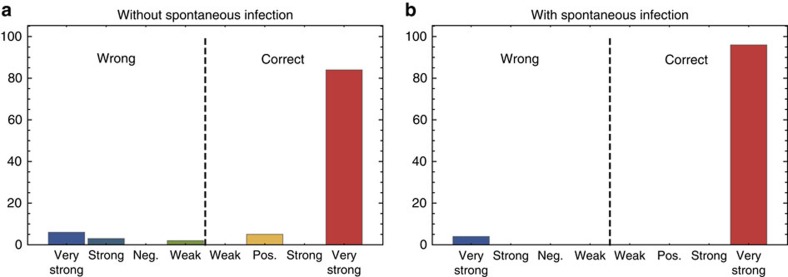
Model selection results for SIRS system.We use the Bayesian information criterion (BIC) for model selection for the SIRS system, with reactions in equation (10) and the additional spontaneous infection reaction in equation (12). The sign of the difference in the BIC numbers of the two models determines if the correct model is selected, and the corresponding magnitude how confident this choice is. We simulated 20 experiments for 5 parameter sets each. The figures show the combined results of these 100 experiments. (a) The true system used to generate the data does not include spontaneous infection. The parameter sets are the same as in Table 3. (b) The true system used to generate the data does include spontaneous infection. The parameter sets are the same as in Table 3, but with modified bimolecular infection rate that we set to k=10, 5, 10, 100 and 10, respectively. The spontaneous infection rate is set to v=0.002 for all parameter sets. In both cases, we observe that our method selects the correct model in >80% of the cases, and in most of these cases with ‘very strong' confidence. This demonstrates the strong performance of our method for this model selection problem.